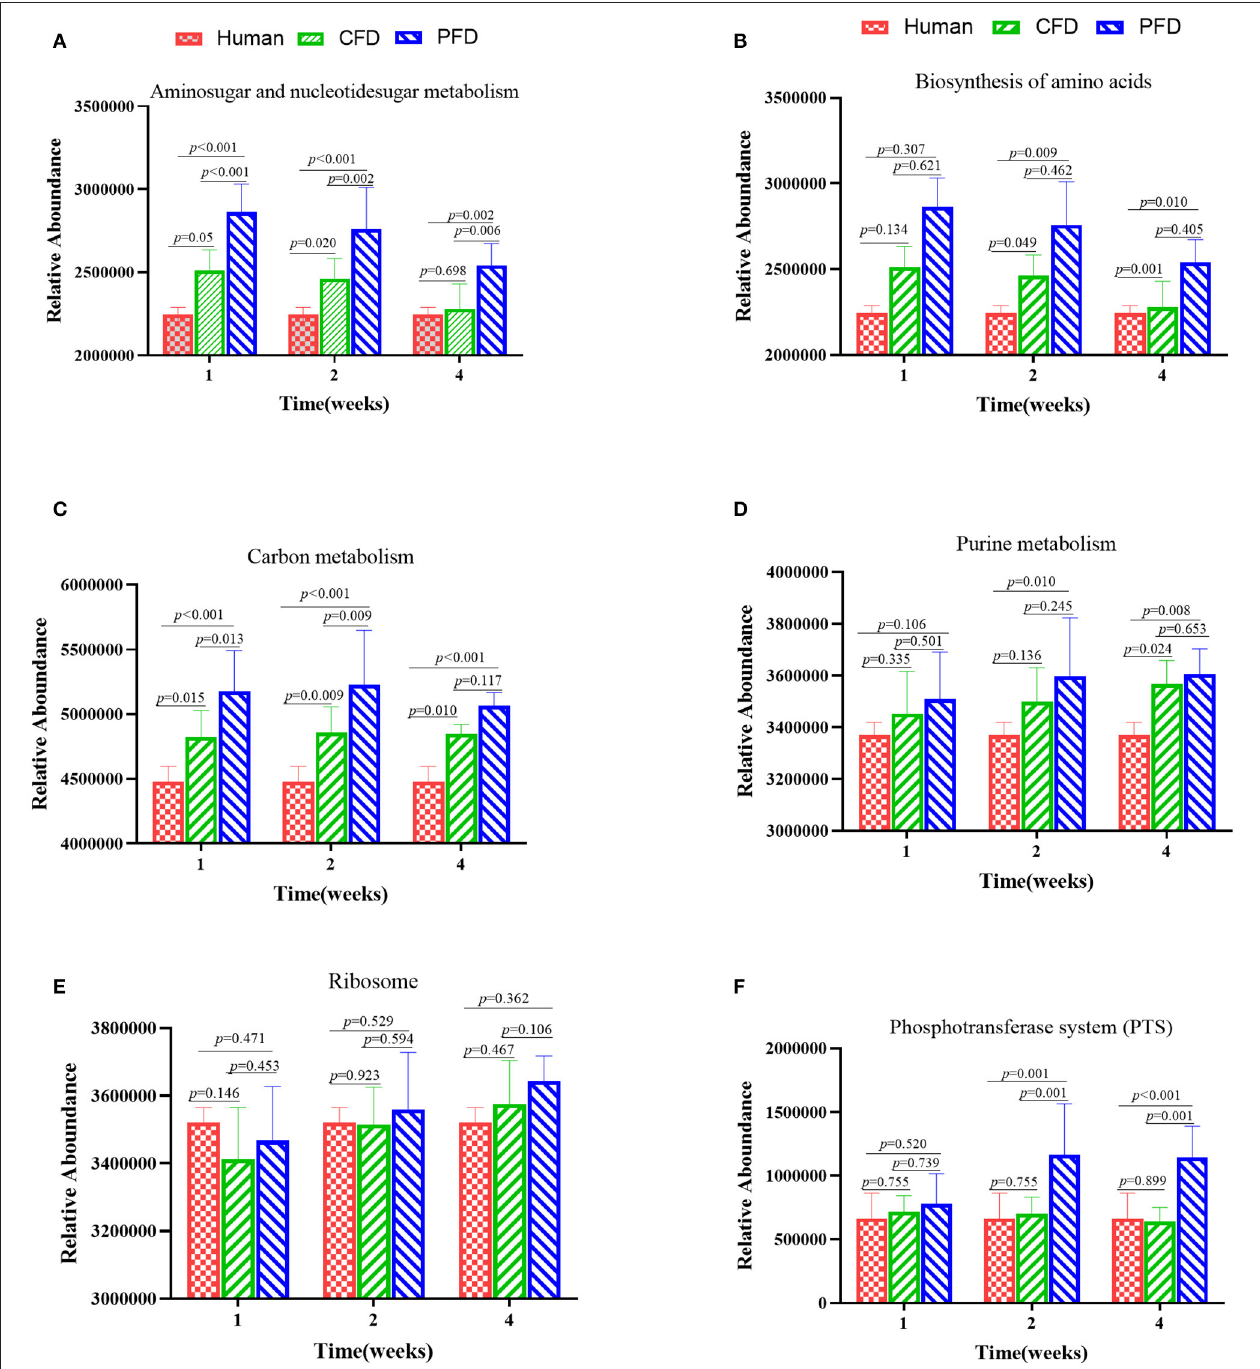
FIGURE 7 | Altered metabolic pathways of the colonic microbiota among the groups in the KEGG database (A–F) . (A) Aminosugar and nucleotidesugar metabolism; (B) Biosynthesis of amino acids; (C) Carbon metabolish; (D) Purine metabolism; (E) Ribosome; (F) Phosphotransferase system (PTS). The results were showed as mean ± SD and filtered according to the Kruskal-Wallis H-test. Statistical significance was denoted by p